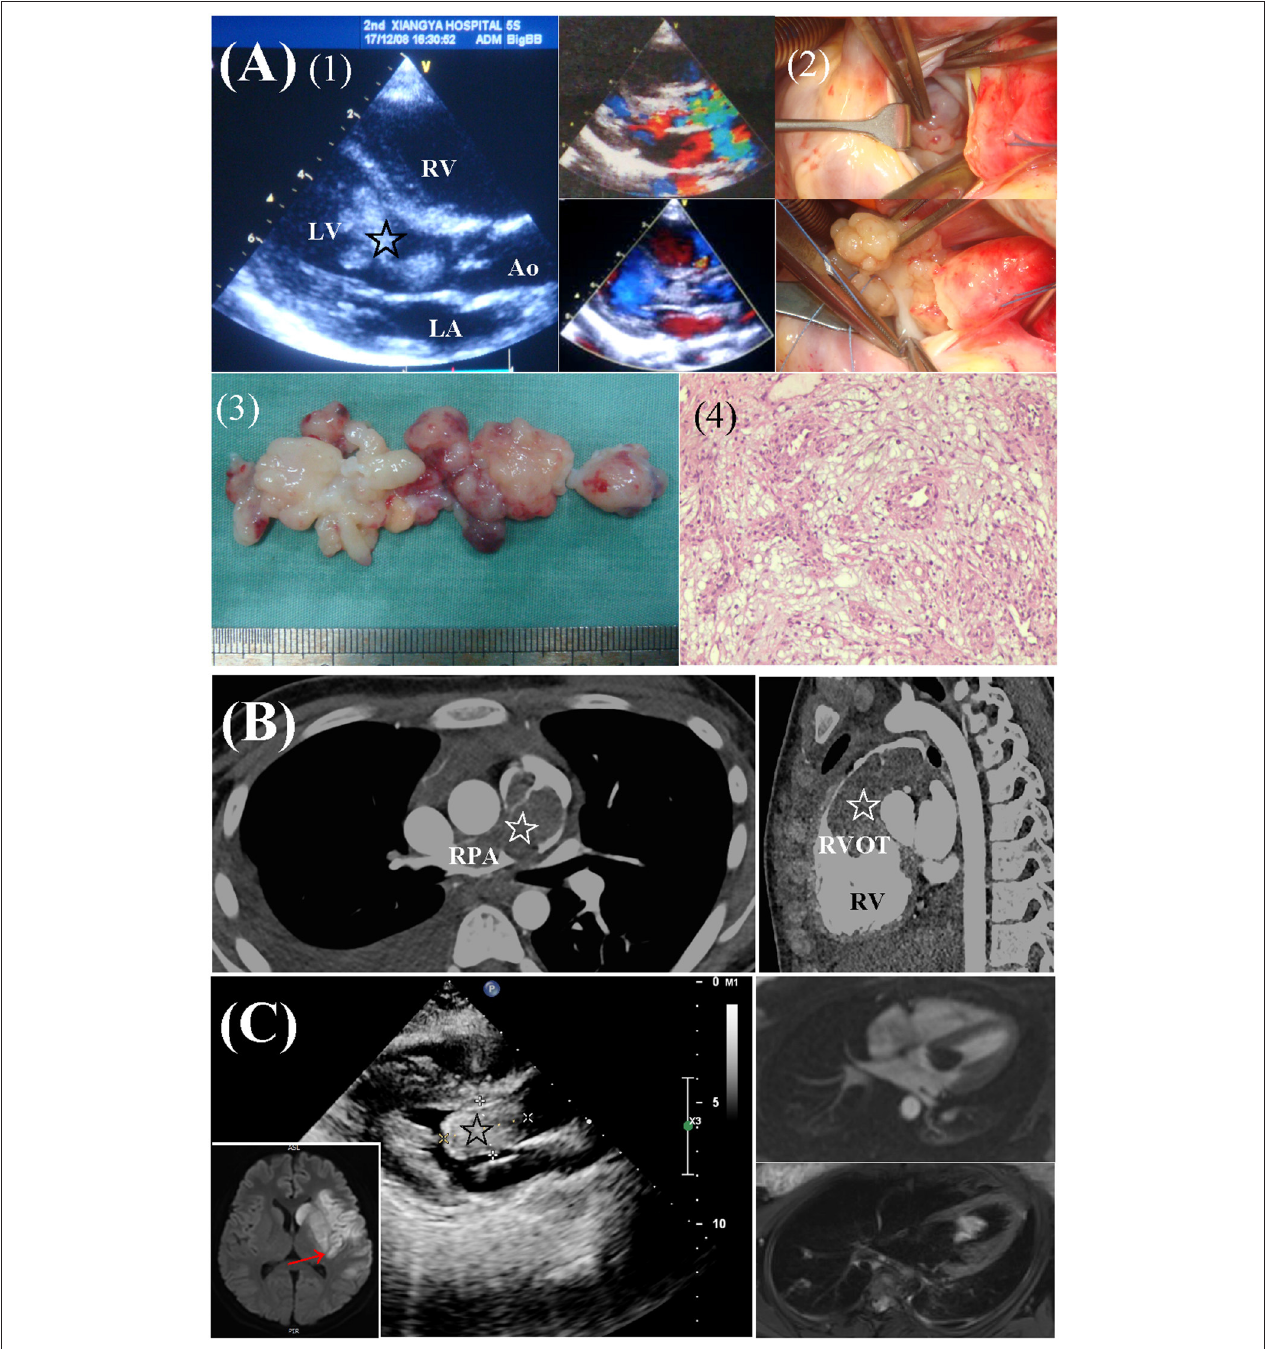
FIGURE 2 | Preoperative workups and surgical resection of ventricular myxomas. (A) Left ventricular myxoma in a 6.2-year-old male. (1) Echocardiography revealed a lobulated, mobile mass (star) obstructing the LV outflow tract. (2) Surgical exploration and complete removal of the mass through a transverse aortic incision. (3, 4) Gross specimen and histologic examination of the mass, typical of myxoma. (B) A 14.5-year-old female presented with dyspnea and edema. CTA revealed a large mass (star) in RV, extending from the RVOT to branch pulmonary arteries. (C) A 17.2-year-old female presented with right hemiplegia and aphasia due to cerebral infarction (red arrow). Echocardiography and MRI revealed a mass (star) located in LV. Ao, aorta; CTA, computed tomography angiography; LA, left atria; LV, left ventricle; RPA, right pulmonary artery; RV, right ventricle; RVOT, right ventricular outflow tract.